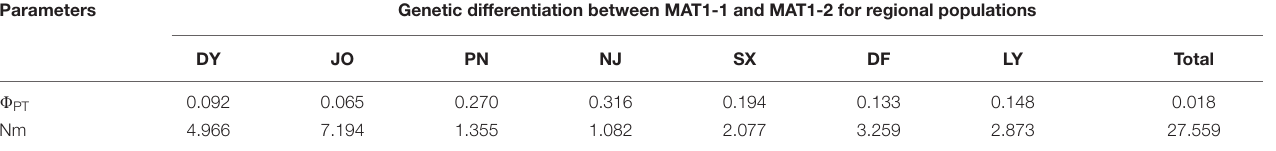
TABLE 4 | Genetic differentiation ( (cid:56) PT ) between the two mating type populations of Setosphaeria turcica from seven regions in Fujian Province based on analyses of inter-simple sequence repeat markers. Parameters Genetic differentiation between MAT1-1 and MAT1-2 for regional populations